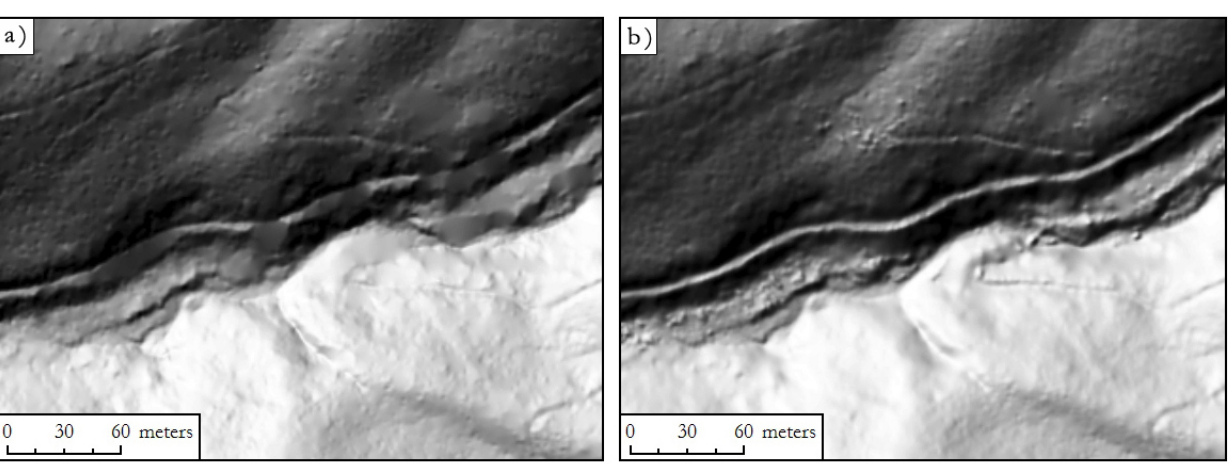
Figure 5. (a) Road topography degraded by over-filtering and removal of true ground returns, and (b) improvements in road topography after